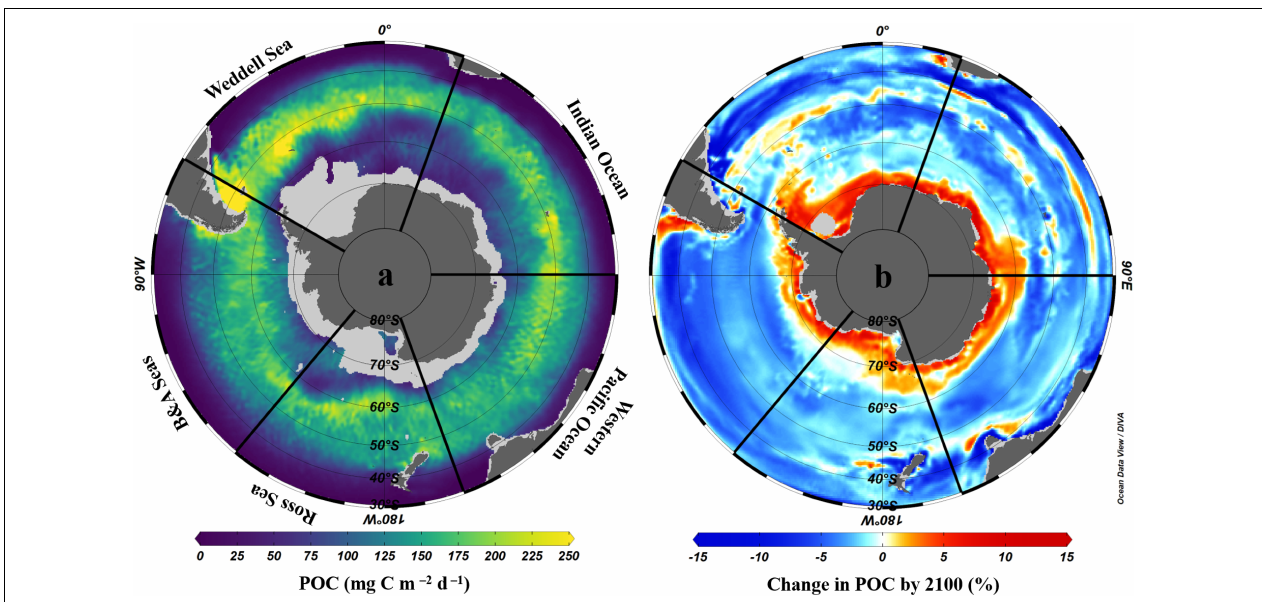
FIGURE 7 | Mean annual POC export at 100 m across the Southern Ocean; (a) present day (2003–2016) from LIDAR data using the Britten et al. (2017) algorithm as in Arteaga et al. (2018) and (b) mean change by the year 2100 according to eight CMIP5 models following methods used in Cavan et al. (2019b). Data are interpolated using the DIVA method in Ocean Data View software (Schlitzer, 2018), with scale-length for Y and X of 2 per mille. The Southern Ocean sectors are named as: Weddell Sea, Indian Ocean, Western Pacific Ocean, Ross Sea, and Bellingshausen and Amundsen